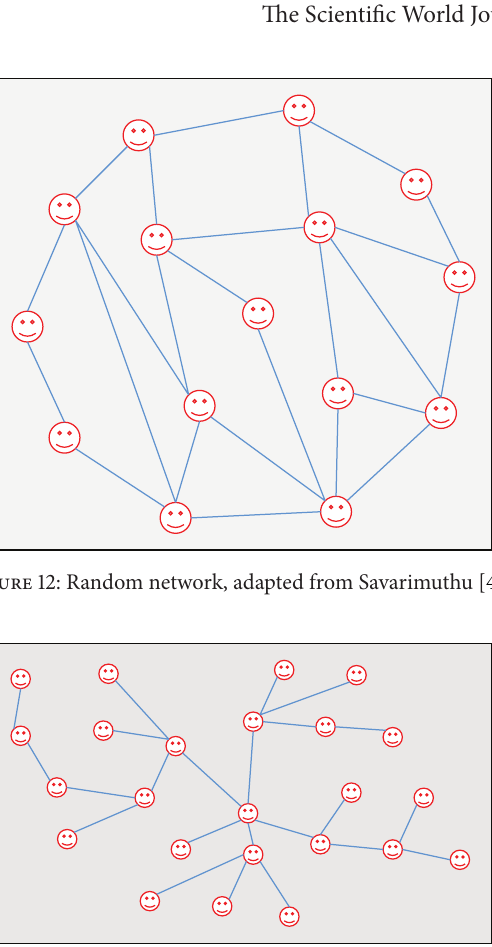
Figure 13: Scale-free network, adapted from Savarimuthu